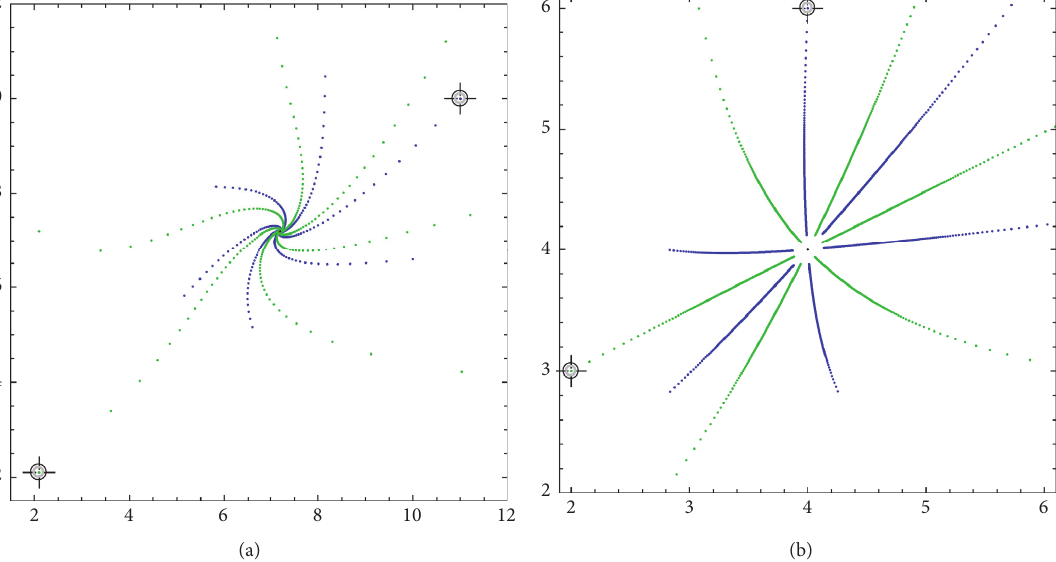
Figure 4: Trajectories for p � 3 . 2 and q � 3 (a) and p � 1 . 5 and q � 1 . 5